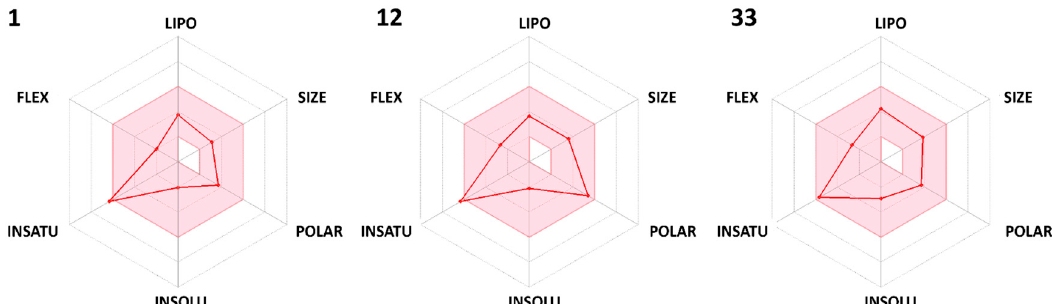
Figure 5. ADME profile of dihydropyrimidone derivatives ( 1 , 12, and 33 ) predicted by SwissADME server. The pink region represents the optimal region for each physiochemical property.